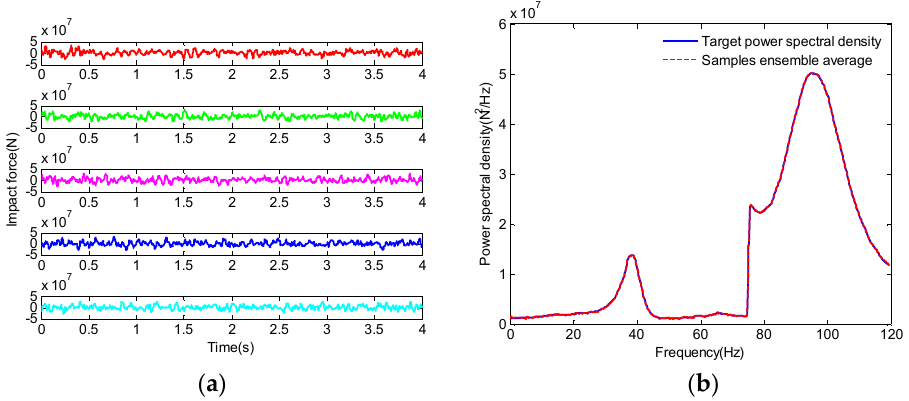
Figure 1. ( a ) Typical time-history sample of wheel-rail impact force. ( b ) Comparison of ensemble average of the impact samples and target PSD.